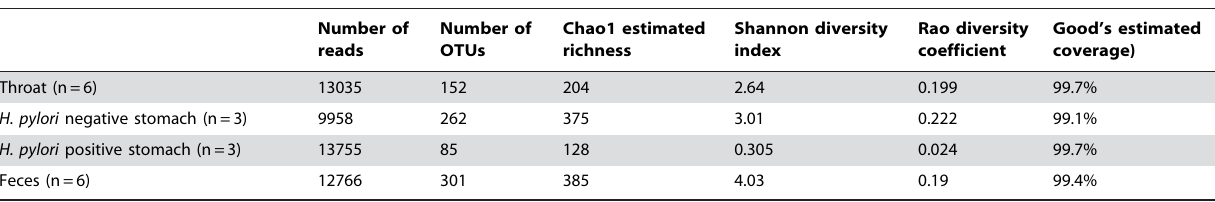
Table 2. Estimations of diversity within different sample groups.